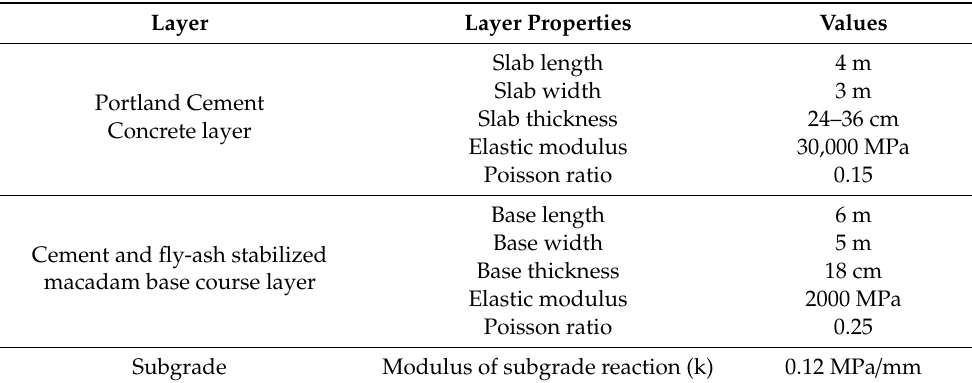
Table 1. The characteristics of the 3D finite